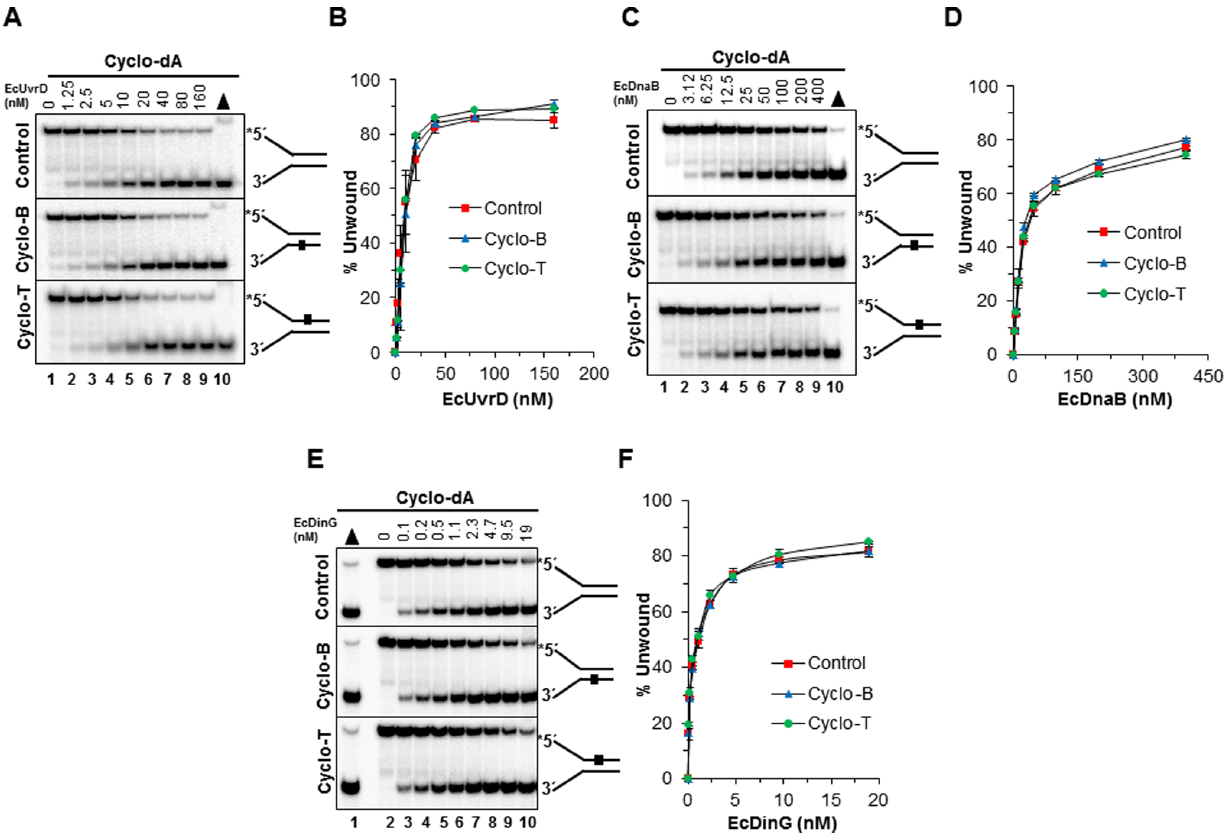
Figure 4. Effect of a site- and strand-specific cyclopurine lesion on EcUvrD, EcDnaB or EcDinG helicase activity. Helicase reactions were carried out by incubating the appropriate EcUvrD, EcDnaB or EcDinG concentrations with 0.5 nM forked duplex DNA that contained a cyclopurine lesion in the top strand (nontranslocating-Cyclo T), bottom strand (translocating-Cyclo B), or neither strand (Control) at 37 u C for 15 min under standard helicase assay conditions described in the Materials and Methods. A, EcUvrD unwinding of undamaged and cyclo dA damaged DNA substrates. Lane 1, no enzyme control; lanes 2–9, indicated concentrations of EcUvrD; lane 10, heat-denatured DNA substrate control. B, Quantification of EcUvrD helicase activity on cdA substrates with error bars. C, EcDnaB unwinding of undamaged and cyclo dA damaged DNA substrates. Lane 1, no enzyme control; lanes 2–9, indicated concentrations of EcDnaB; lane 10, heat-denatured DNA substrate control. D, Quantification of EcDnaB helicase activity on cdA substrates with error bars. E, EcDinG unwinding of undamaged and cyclo dA damaged DNA substrates. Lane 1, heat-denatured DNA substrate control; lane 2, no enzyme control; lanes 3–10, indicated concentrations of EcDinG. F, Quantification of EcDinG helicase activity on cdA substrates with error